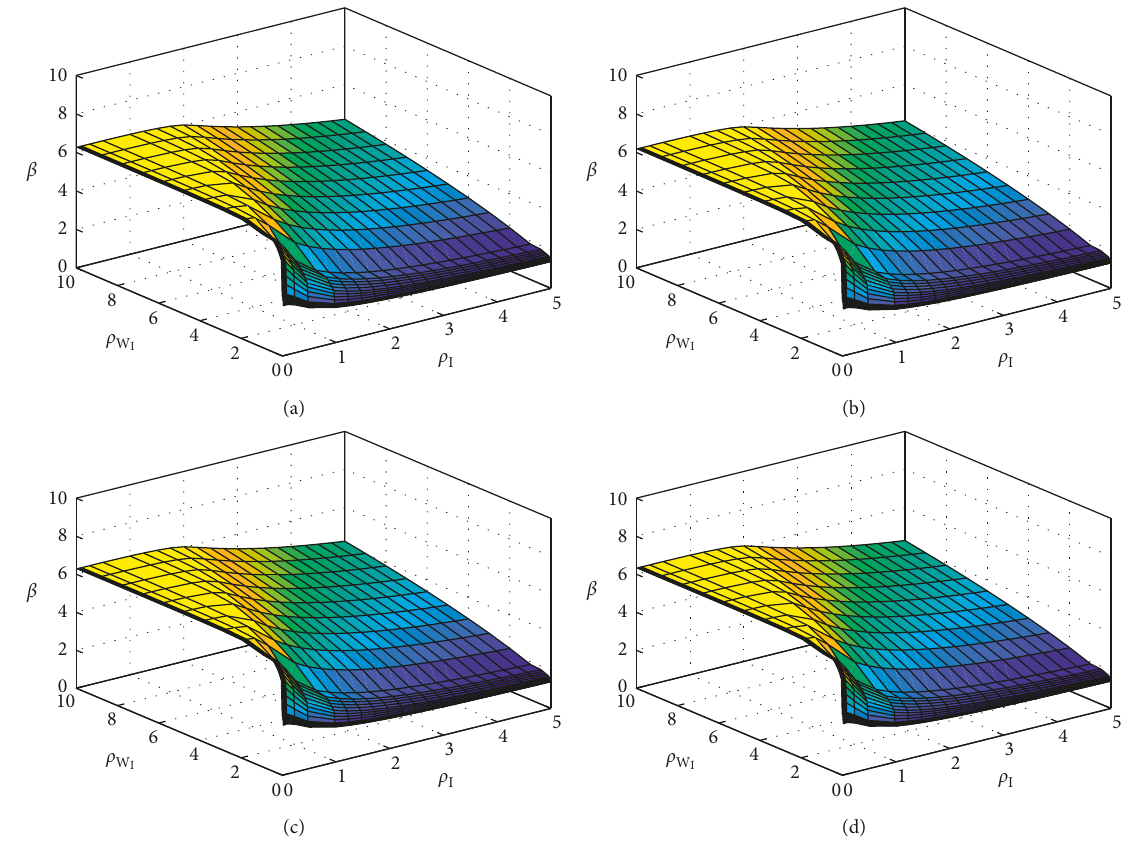
Figure 4: Reliability indices for strength calculation of axially loaded member. (a) Q235: d > 16 ∼ 40 mm, (b) Q235: d > 40 ∼ 60 mm, (c) Q345: d > 16 ∼ 35 mm, and (d) Q345: d > 35 ∼ 50